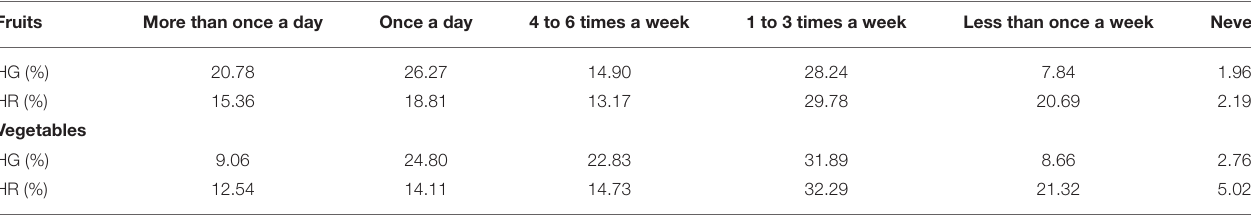
TABLE 2 | Fruit and vegetable consumption frequencies of the Hungarian general and Roma populations.